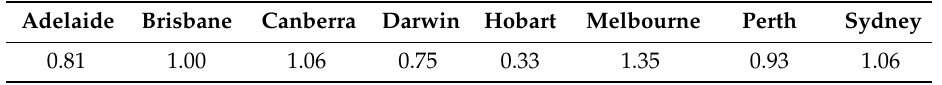
Table 8. Emission factors for the consumption of electricity in Australian capital cities (kg CO 2 -e/kWh) [63].